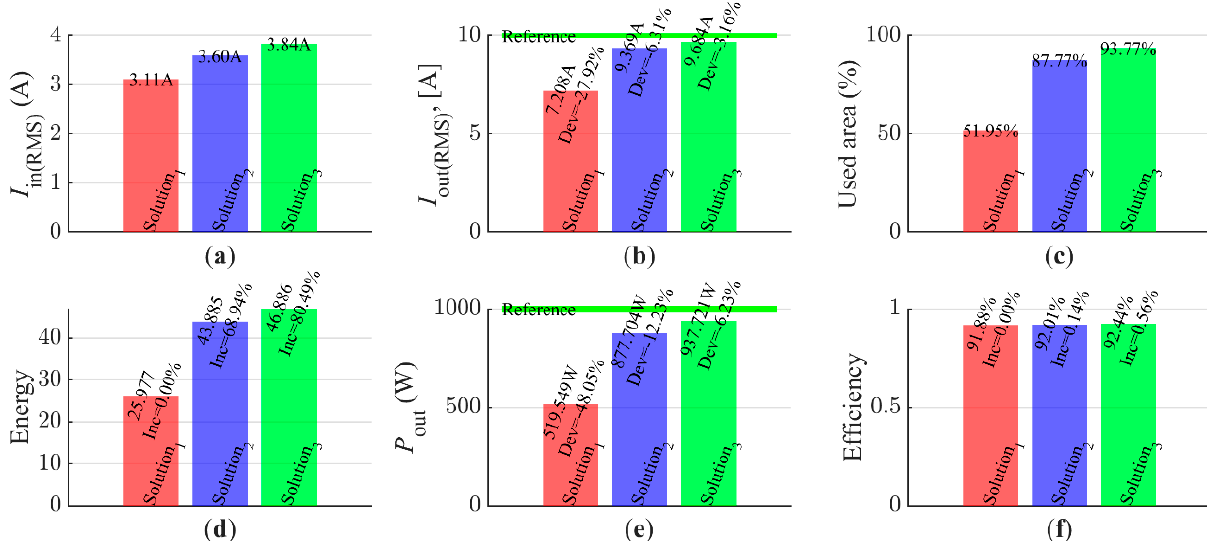
Figure 14. Comparison of three solutions: ( a ) input current I in(RMS) ; ( b ) output current I out(RMS) ; ( c ) used track area; ( d ) transmitted energy E; ( e ) transmitted power P out(RMS) ; ( f ) system efficiency.